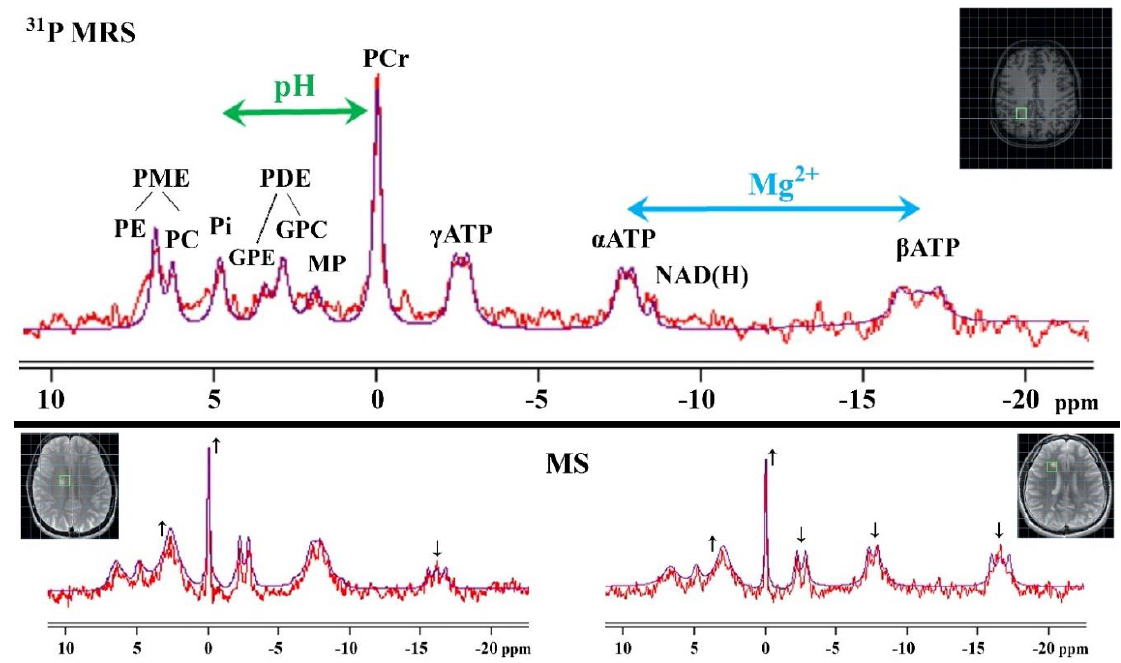
Figure 5. Visualization of phosphorus-31 magnetic resonance spectroscopy ( 31 H MRS). 31 P MRS brain tissue examination represents the measured signal from the voxel depicted on MRI in green square. The following metabolite peaks are shown: phosphoethanolamine (PE), phosphocholine (PC), phosphomonoesters (PME), inorganic phosphate (Pi), glycerophosphoethanolamine (GPE), glycerophosphocholine (GPC), phosphodiesters (PDE), membrane phospholipids (MP), phosphocreatine (PCr), nicotinamide adenine dinucleotide (NAD(H)), and adenosine triphosphates ( α -, β -, γ -ATP). Graphical representations of the indirect pH (chemical shift of Pi and PCr depicted as green arrow) and [Mg 2 + ] evaluation (chemical shift of α -ATP and β -ATP depicted as blue arrow) are also indicated in the fitted MR spectra. The 31 P MRS spectra for a healthy (at the top) and MS-a ff ected (at the bottom) brain are also depicted together with the highlight of the typical metabolic peaks changes via small black arrows ( ↓ : decreased, ↑ :